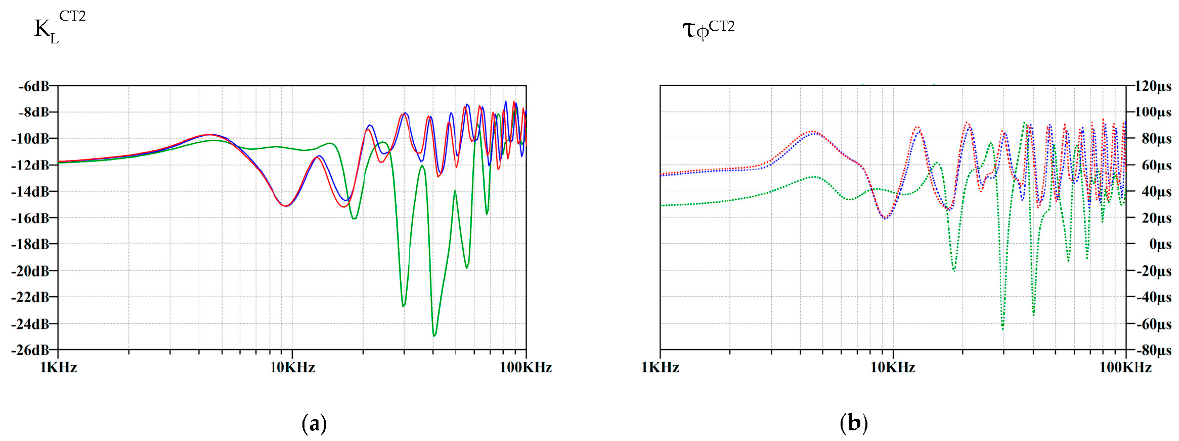
Figure 10. Frequency ( a ) and group delay ( b ) characteristics of the type 2 cable—CT2 (green, 0 T; blue, 5 T; and red, 50 T).